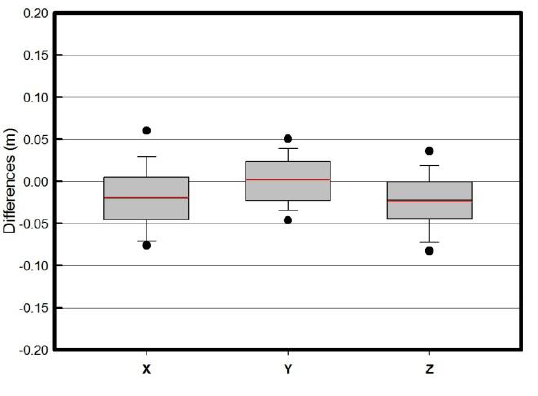
Figure 7. Differences between CMP-Trimble® PIVOT™ and RTX solutions, for the components of position